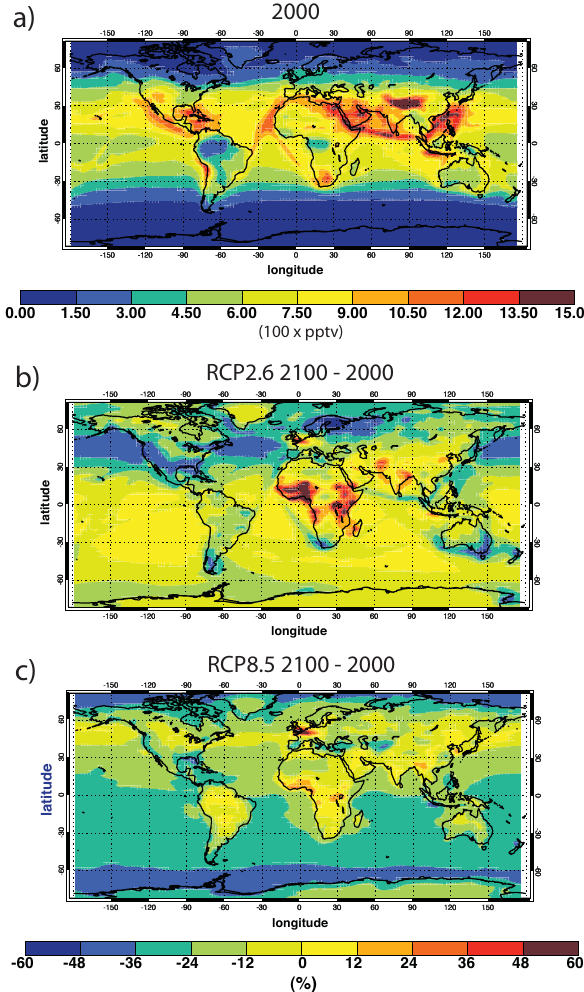
Fig. 6. Multi-model mean surface annual mean OH concentration for present day (a) , and its change between 2000 and 2100 in RCP2.6 (b) and RCP8.5 (c) . The bottom model layer results have been used as representative for the surface. Please see Figs. S2 and S3 for surface OH changes in individual